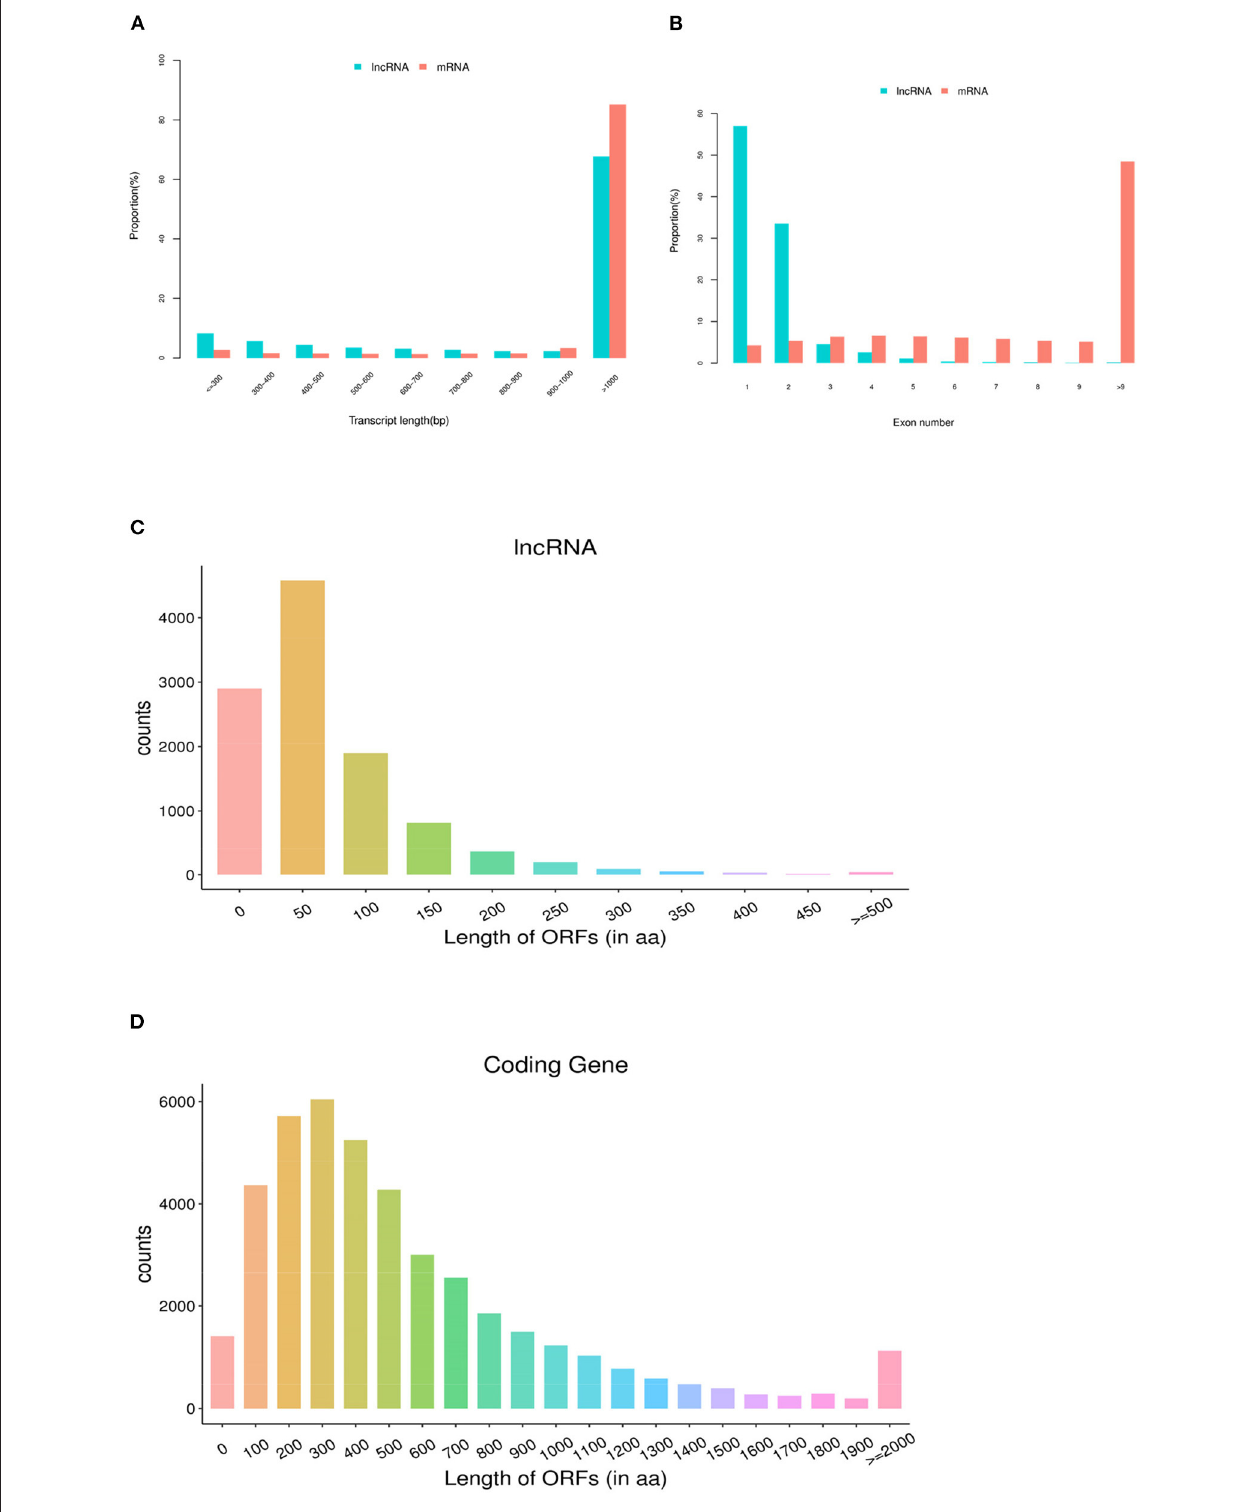
FIGURE 2 | Genomic features of lncRNAs in pig ovaries. (A) The transcript length distribution of lncRNAs and mRNAs. (B) The exon number distribution of lncRNAs and mRNAs. (C) The ORF length distribution of lncRNAs. (D) The ORF length distribution of mRNAs.